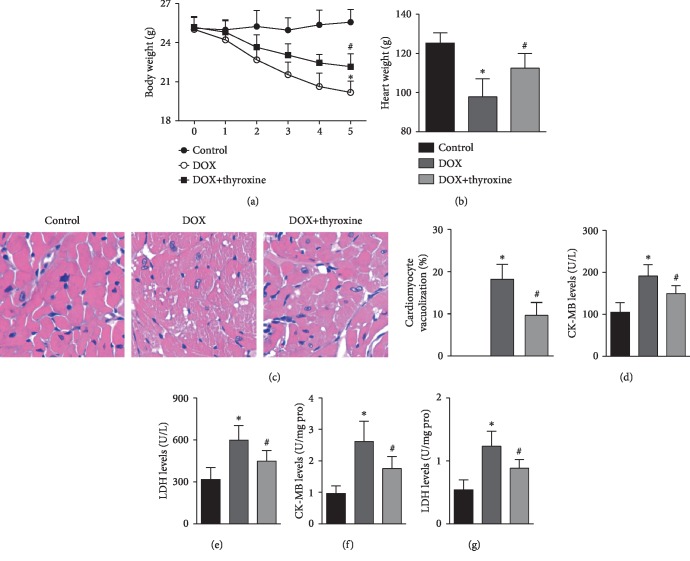
Effects of thyroxine on DOX-induced cardiac injury. (a) Body weights in the four groups were measured at different time points; N = 12 in each group. (b) Heart weights were measured at the end of the fifth day in each group; N = 12 in each group. (c) Heart sections were stained with HE, and the numbers of vacuolated cardiomyocytes were quantified (200×); N = 6 in each group. (d, e) Serum LDH and CK-MB levels were assessed; N = 12 in each group. (f, g) Heart LDH and CK-MB levels were detected; N = 6 in each group. ∗P < 0.05 vs. control group; #P < 0.01 vs. DOX group.